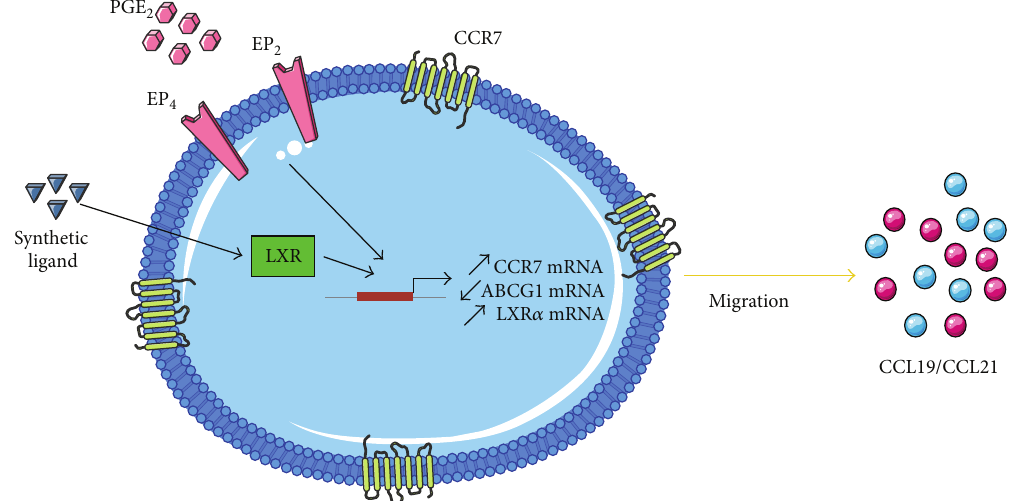
Figure 7: Schematic depicting effects of PGE 2 and LXR activation on CCR7 functionality in MM-1